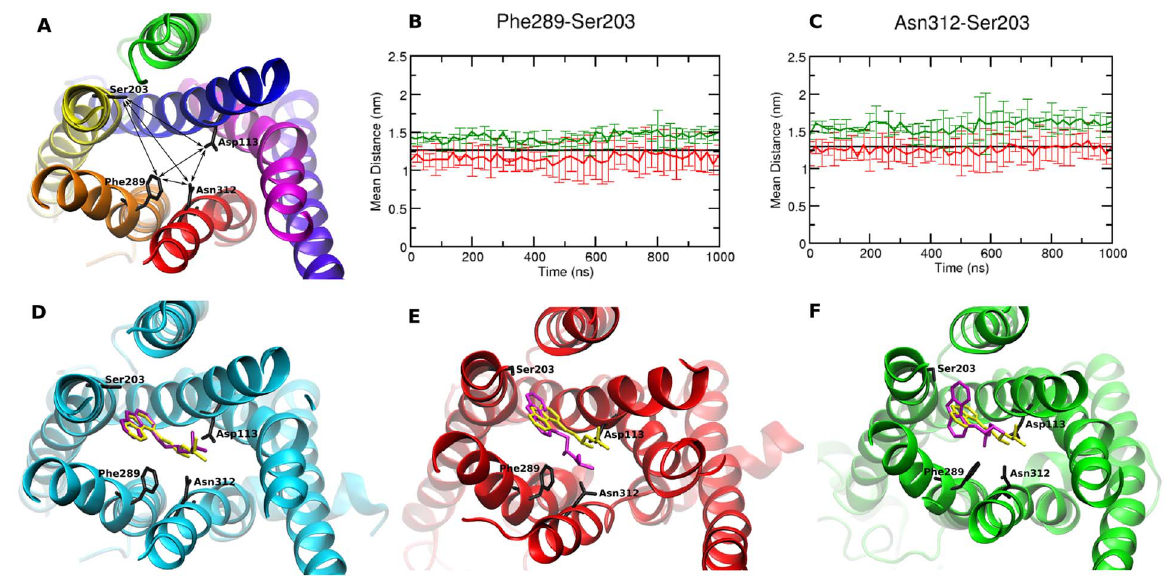
Fig. 7. Characterization of the ligand binding site of b 2 AR variants. (A) Top-view of the b 2 AR represented as ribbons. The residues (113, 203, 289 and 312) that define the topology of the binding site are represented as licorice and the distances between them are indicated by lines. (B) Average distance between residues 289 and 203 for the Arg (red) and Gly (green) variants. (C) Average distance between residues 312 and 203 for the Arg (red) and Gly (green) variants. Docking of carazolol to (D) the 2RH1 structure, (E) Arg variant and (F) Gly variant. The crystal structure pose of carazolol is colored yellow, and the docked pose is colored purple.